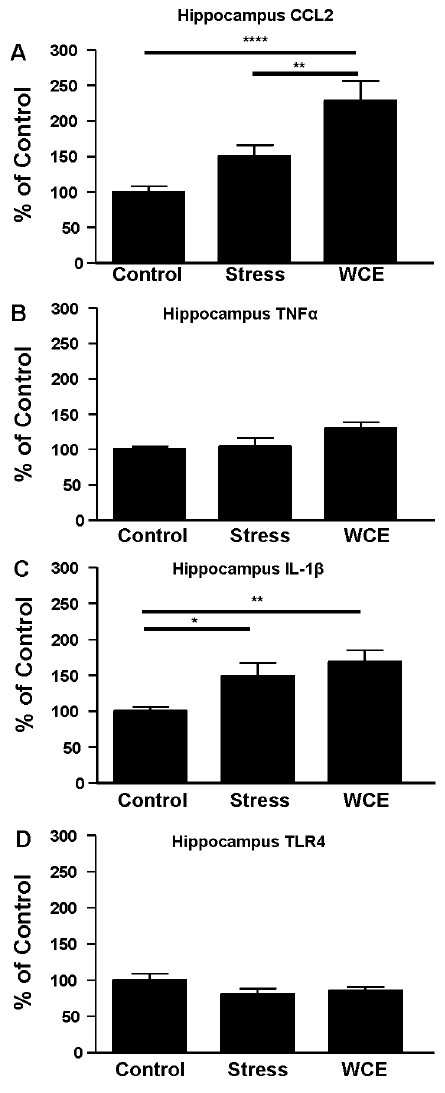
Figure 5. Effects of restraint stress or WCE for hippocampal neuroimmune mRNAs. For CCL2, there